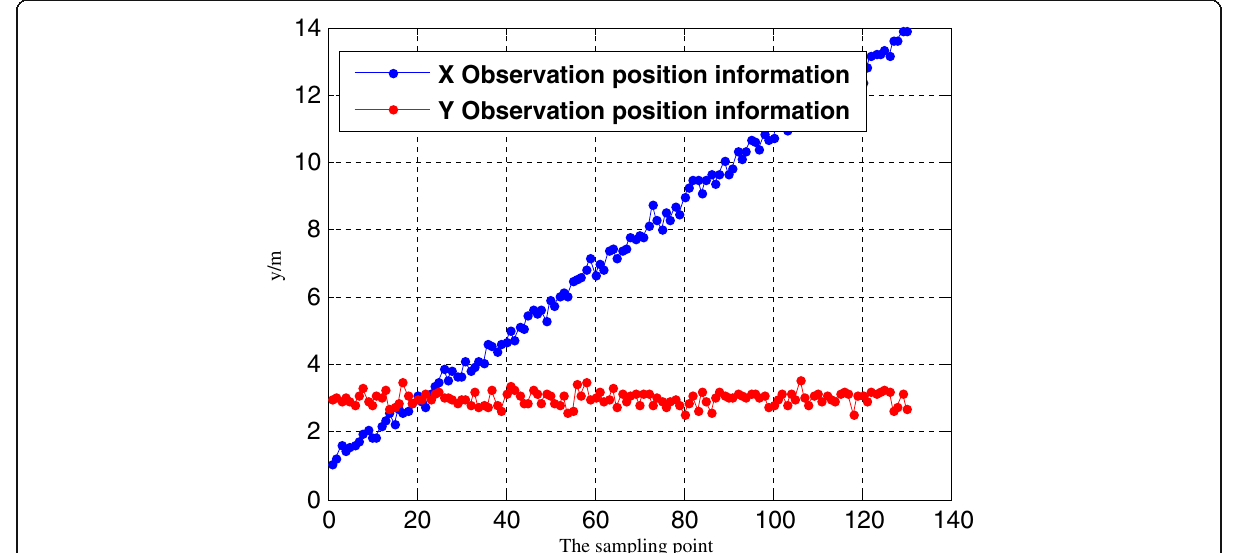
Fig. 5 Observation position information. It can be clearly observed that the initial state is not good for the actual target state, and the error is large. However, as the number of sampling increases, the error